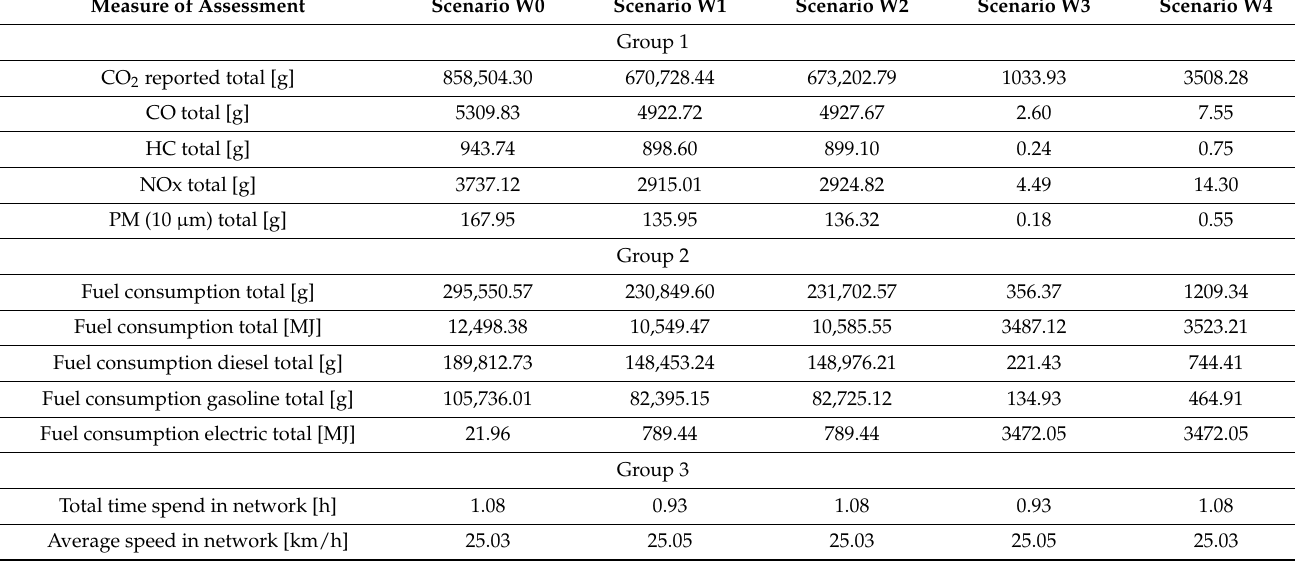
Table 7. The values of the measures for assessing the impact of the share of electric vehicles in traffic at the city centre area on the reduction of exhaust emissions for the reference scenario W0 and for the scenarios W1–W4—analysis for the central areas of the